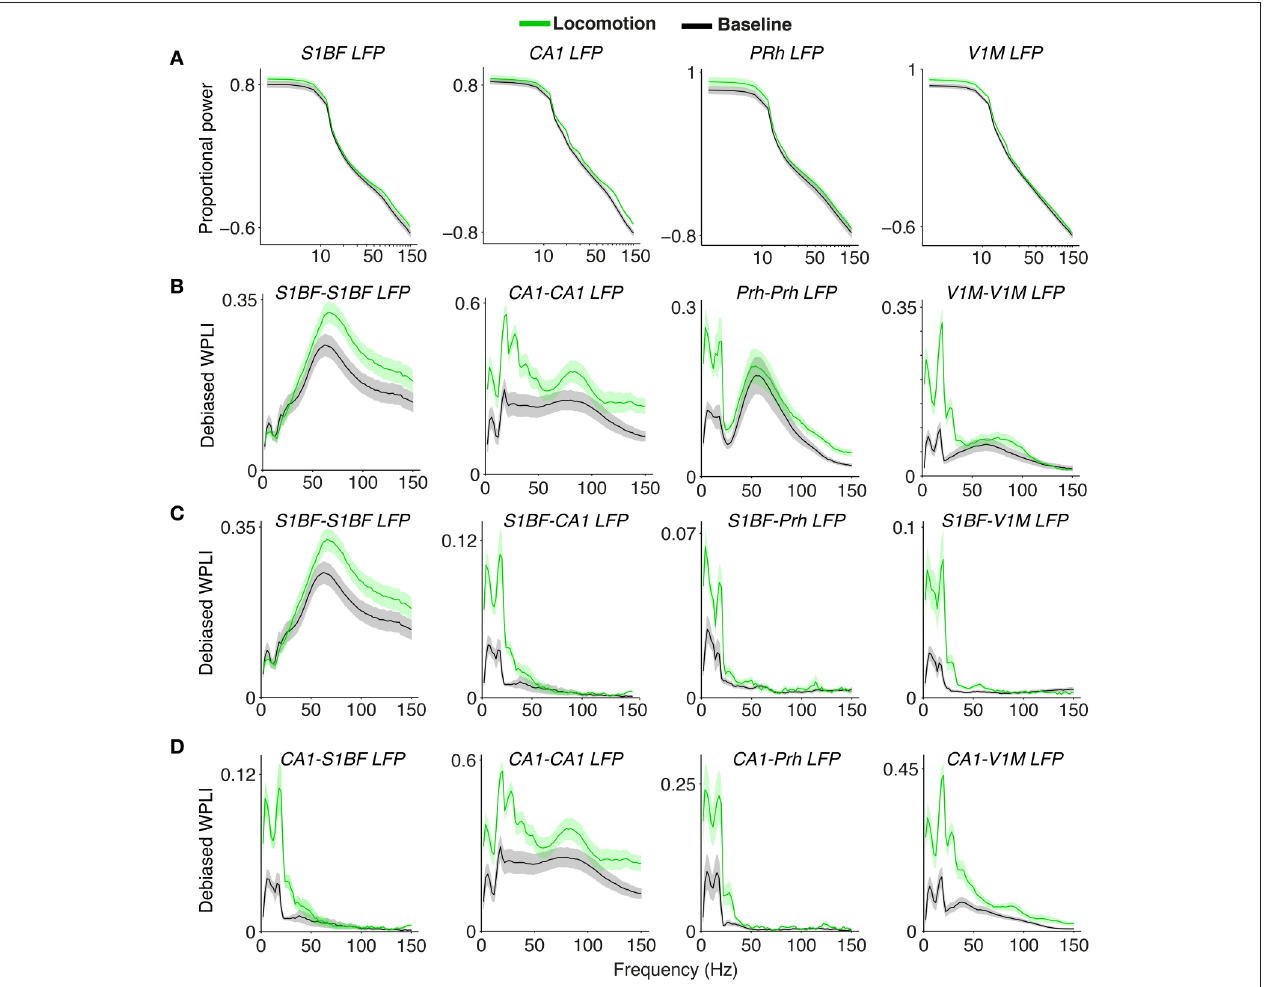
FIGURE 9 | Inter and intra-areal phase-synchronization among S1BF, CA1, V1M, and perirhinal cortex LFPs. (A) Normalized power spectra for the four areas, similar to Figure 1 . (B) Phase-synchronization [debiased WPLI] between LFPs from the same areas, as in Figure 2 . Shadings indicate SEMs across sessions. (C) Phase-synchronization between S1BF LFPs and LFPs from the other areas. First column is shown also in panel (B) . (D) Phase-synchronization between CA1 LFPs and LFPs from other areas. First and second column are also shown in panels (B,C)